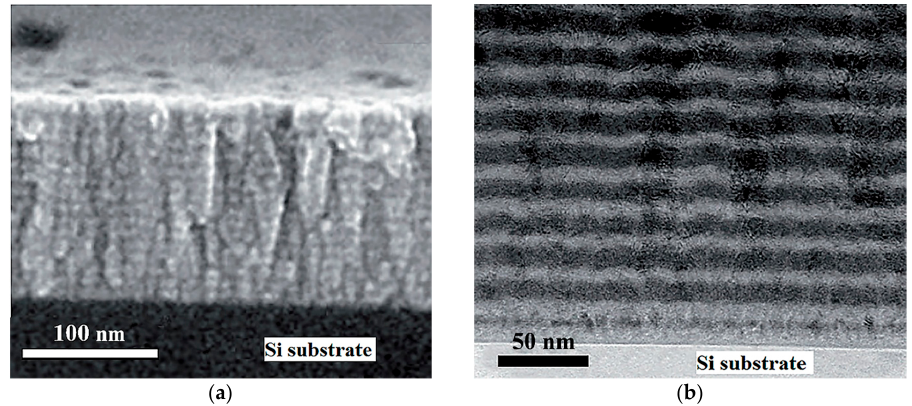
Figure 5. Cross sectional view of the TiN/ZrN multilayer coatings with bilayer thickness of 10 nm: deposited via magnetron sputtering of the silicon substrates ( a ) Scanning electron microscope (SEM) image; ( b ) High resolution transmission electron microscope (HRTEM) image